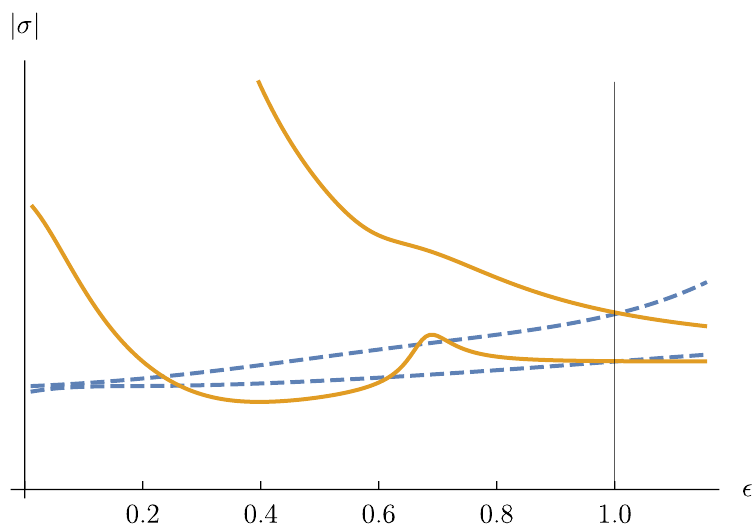
Figure 1 . Convergent solutions at 6 points NMHV using CHY’s inverse soft algorithm. Orange solid lines are solutions coming from 5 points MHV and blue dashed lines are from 5 points